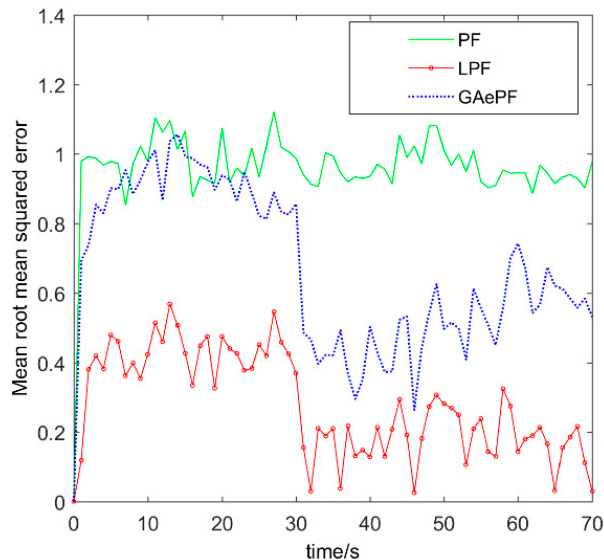
Figure 2. Mean root mean square error (rmse) with observation times for 200 simulations of three algorithms compared.